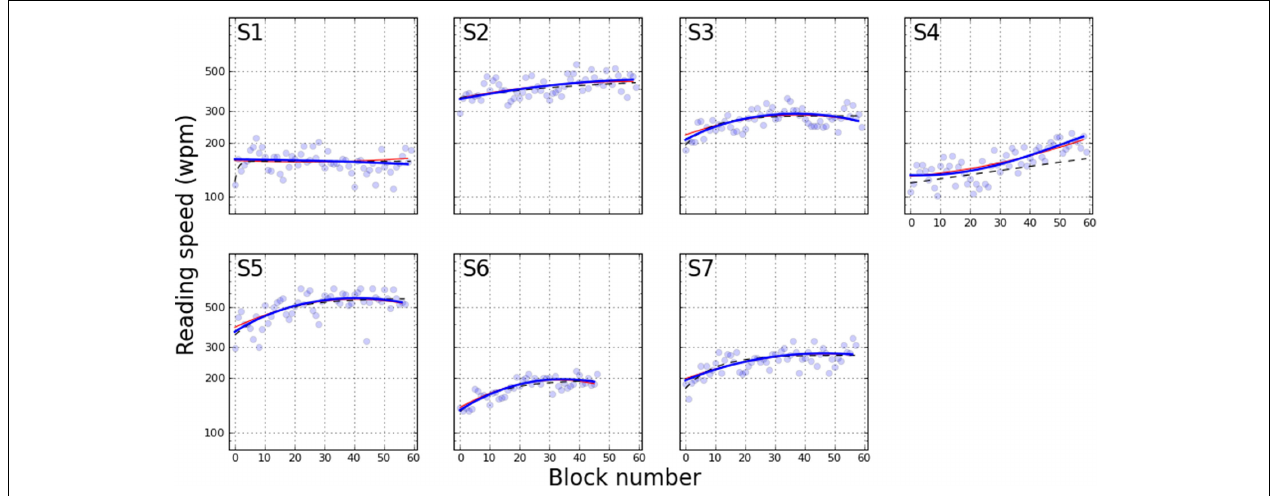
FIGURE 4 | Reading speed across training blocks. The data is derived from Figures 2 , 3 , with conversion specified as reading speed =